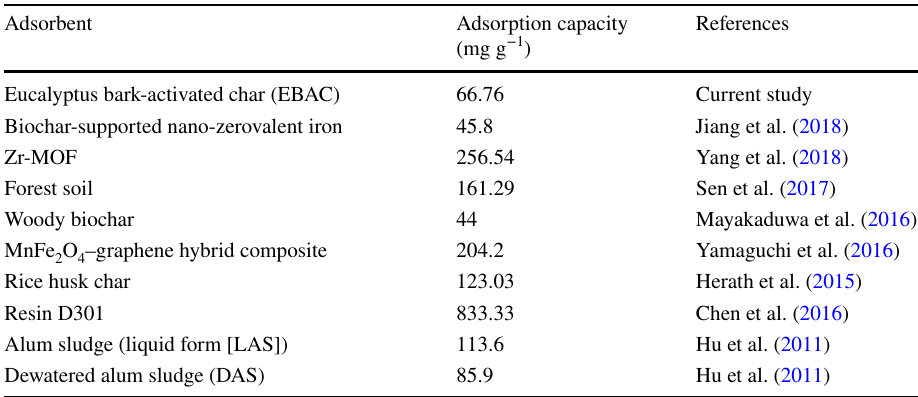
Table 6 Comparison of glyphosate adsorption capacity of various